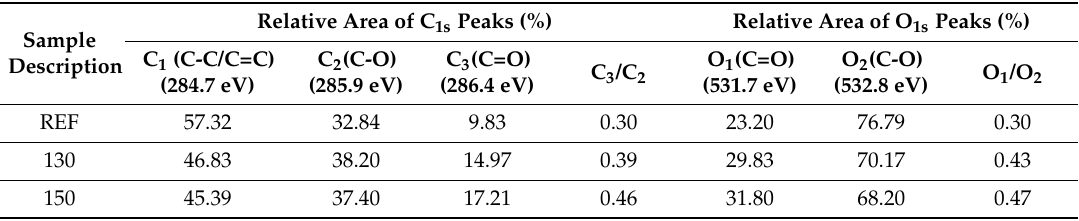
Figure 5. X-ray photoelectron spectroscopy scan of C 1S and O 1S of lignin isolated from treated wood samples: ( a ) Curve fitting of the C 1s peak of reference samples; ( b ) Curve fitting of the C 1s peak under 130 °C; ( c ) Curve fitting of the C 1s peak under 150 °C; ( d ) Curve fitting of the O 1s peak of reference samples; ( e ) Curve fitting of the O 1s peak under 130 °C; ( f ) Curve fitting of the O 1s peak under 150 °C. Table 5. Subpeak area fractions of C 1S and O 1S .